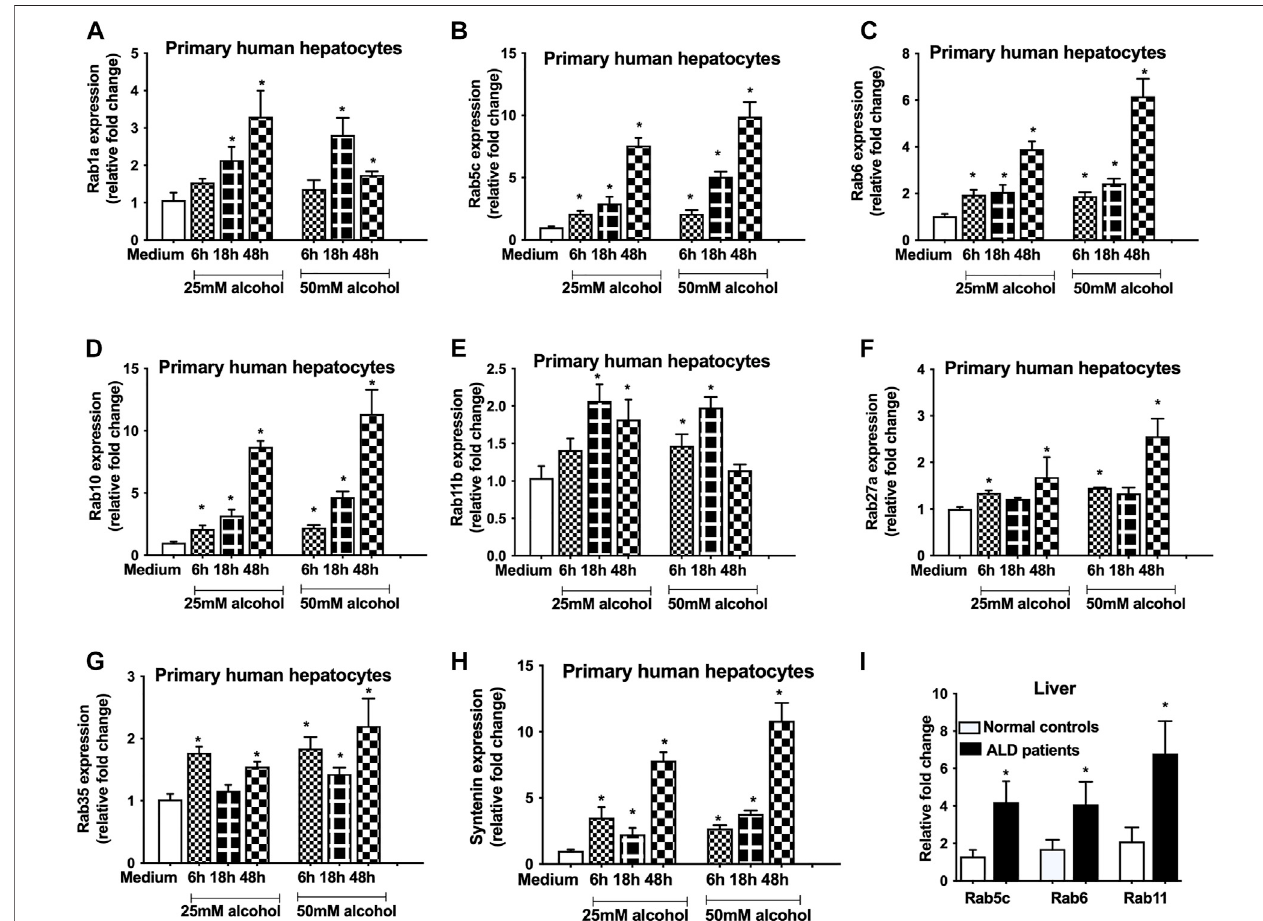
FIGURE1| AlcoholinducestheexpressionofRabsinprimaryhumanhepatocytesandinALDpatients.Primaryhumanhepatocyteswereculturedandtreatedwith different dosage of alcohol (25 and 50 mM) for indicated times. The expression ofRab1a (A) , Rab5c (B) , Rab6 (C) , Rab10 (D) , Rab11b (E) , Rab27a (F) , Rab35 (G) and syntenin (H) wasdetermined byqPCRfromthetotalRNAisolatedfromthecells. Resultsarerepresentativeofthreeindependent experiments. TotalRNAwasextracted fromtheliversofnormalcontrolsandALDpatients(n (cid:1) 9)andexpressionofRab5c,Rab6andRab11wasevaluatedbyqPCR (I) .18swasusedtonormalizethecq values. Data represent mean ± SEM. Mann-Whitney test was employed for statistical analysis. *indicates p < 0.05 versus control cells (A-H) or normal controls (I) .